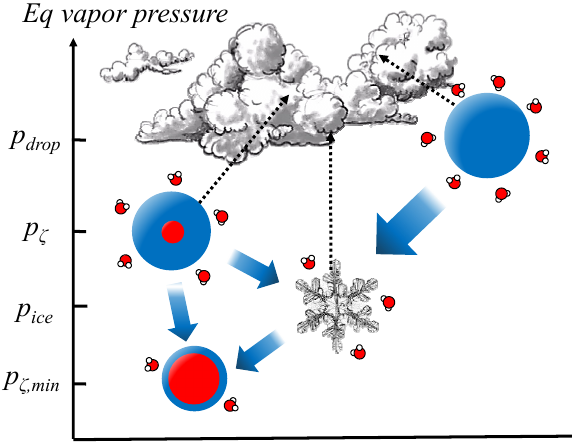
Figure 6. Schematic of the equilibrium vapor pressures over droplets, predeliquesced particles, and ice particles, where gradi- ents lead to Wegener–Bergeron–Findeisen processing. The range of equilibrium vapor pressures above predeliquesced thin films strad- dle the equilibrium vapor pressure over ice p ice , resulting in a more stable coexistence between ice and predeliquesced particles, relative to liquid